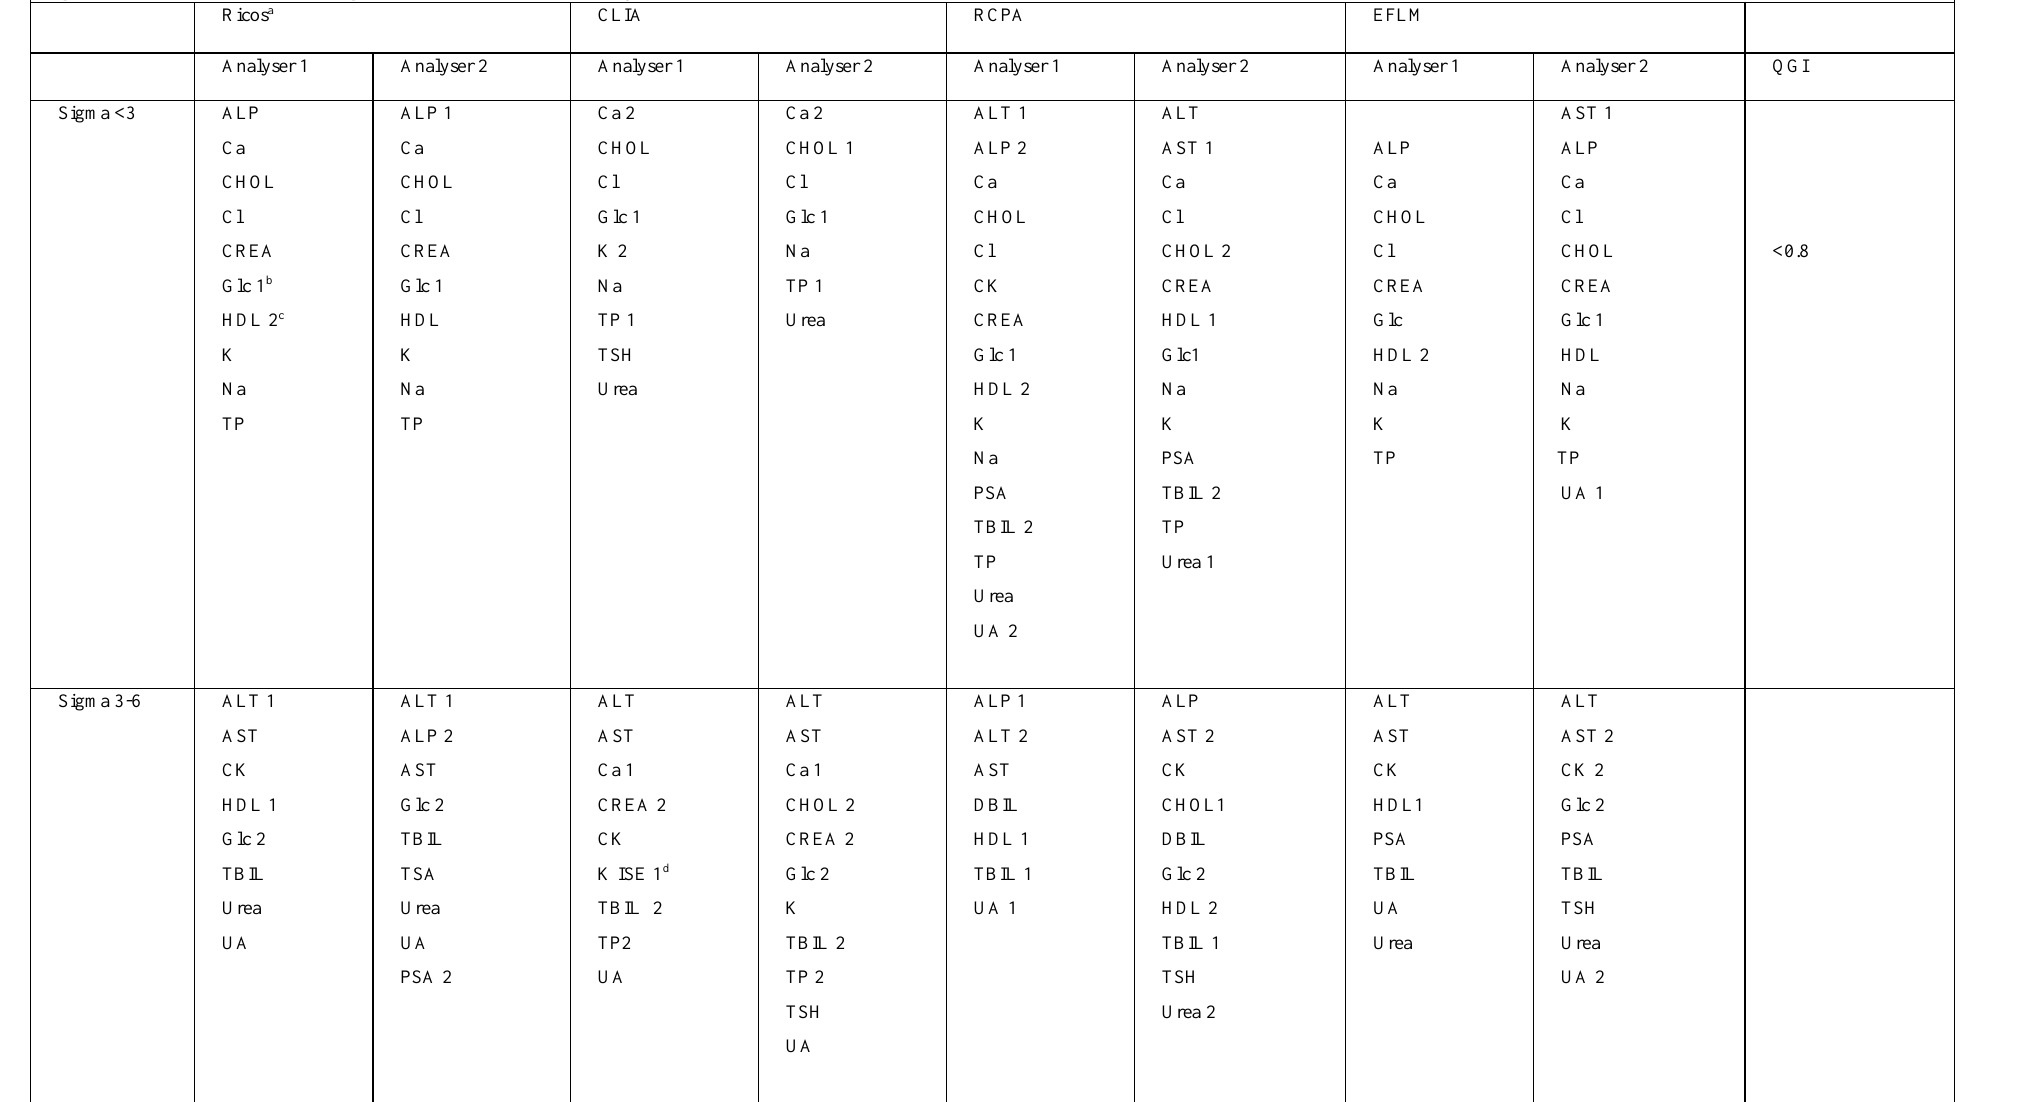
Supplementary Table 1: Sigma values of analytes tested on two chemistry analysers (Analyser 1 and Analyser 2) based on different total allowable error guidelines, Johannesburg, South Africa, January 2017 – December